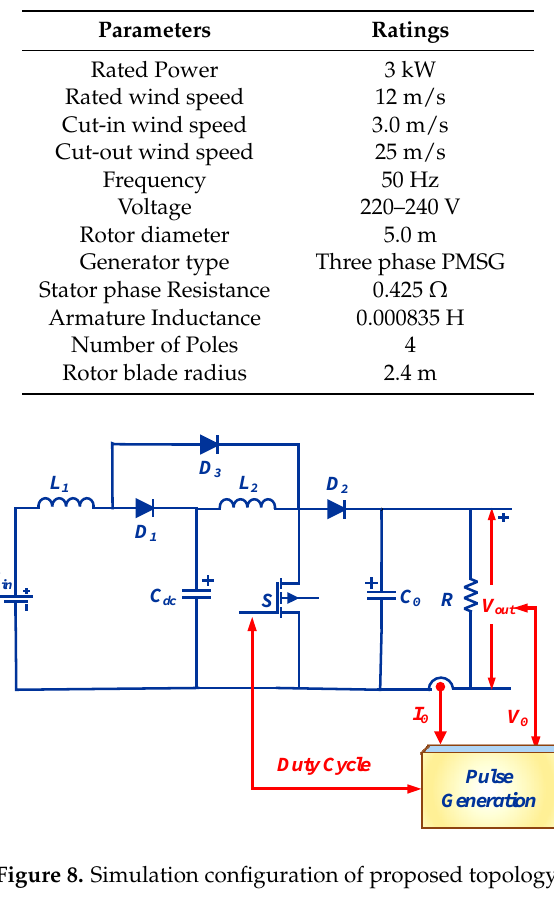
Table 1. Parameters of Aeolos 3 kW system. PMSG: permanent magnet synchronous generator.